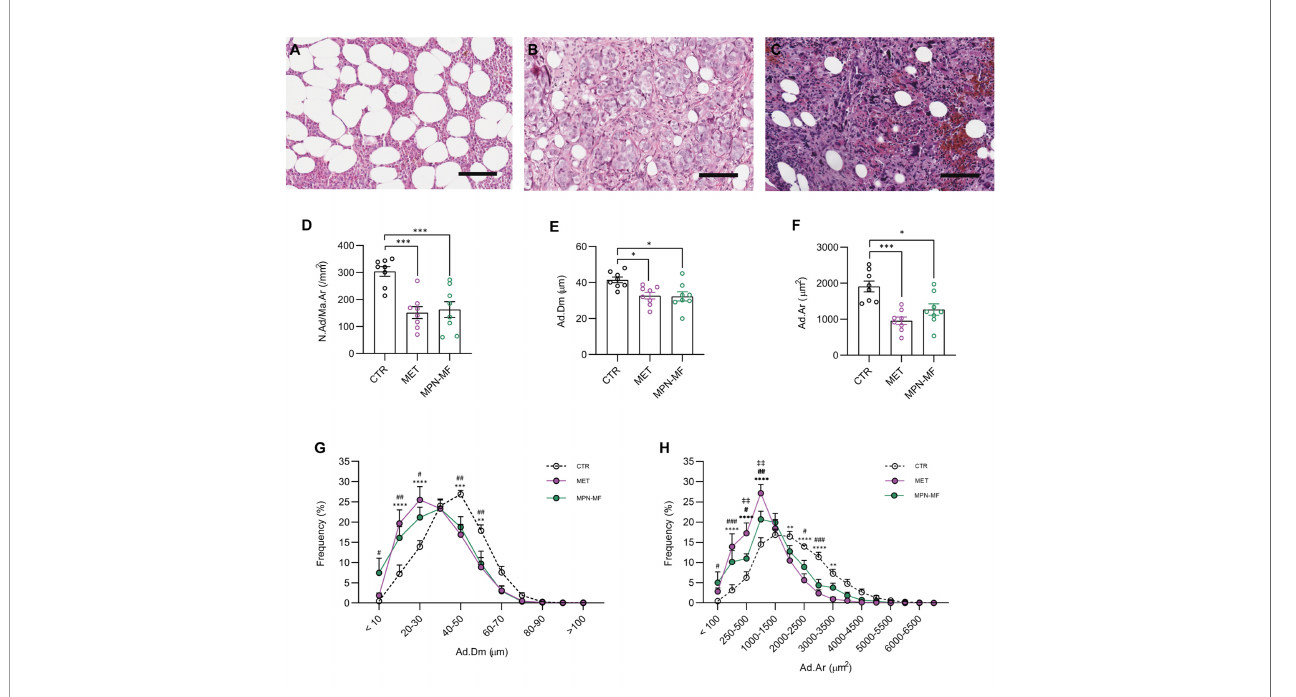
FIGURE 1 | Representative histologic images of CTR (A) , MET (B) and MPN-MF (C) bone biopsies. Histomorphometric analysis of BMAds number ( D , N.Ad/Ma.Ar), diameter ( E , Ad.Dm) and area ( F, Ad.Ar). Frequency distribution curves of BMAds diameter and area are illustrated in (G , H) , respectively. Scale bar: 100 µm. In (D – F) : * p < 0.05, *** p < 0.001; In (G , H) : CTR vs MET: ** p < 0.01, *** p < 0.001, **** p < 0.0001; CTR vs MPN-MF: # p < 0.05 and ## p < 0.01, ### p < 0.001; MET vs MPN-MF: ‡‡ p < 0.01